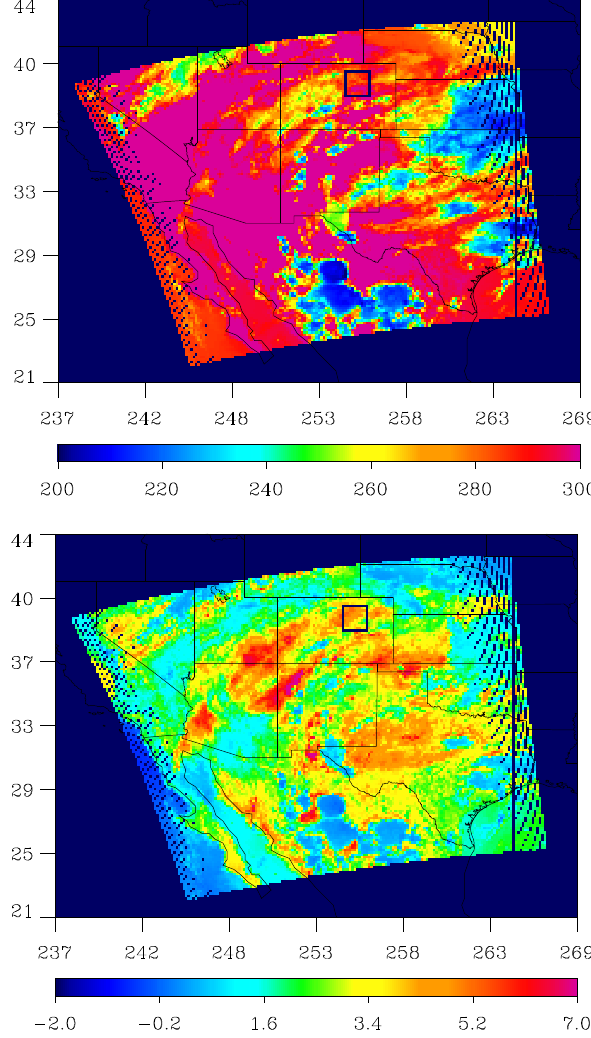
Fig. 4. Figure shows the MODIS 11.0µm brightness temperature (top panel) and the 11.0µm minus 12.0µm BTD (bottom panel) for the 7 June 2015 GMT overpass. The SPEC 25 Learjet was located in thin cirrus along the Front Range of Colorado as shown by the high BTD areas within the black box in the bottom panel. High val- ues of BTD for the cirrus suggest clouds dominated radiatively by small crystals. The low BTD areas in the lower-right portion of the black box and corresponding high 11.0µm brightness temperatures indicate regions of clear-sky or very thin cirrus